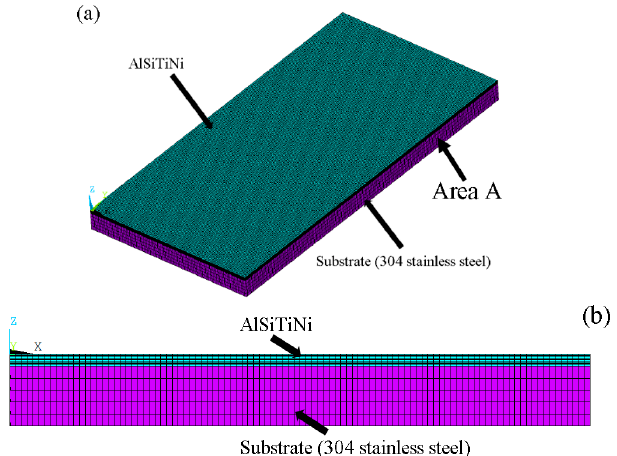
Figure 5. The mesh of the finite element (FE) model: ( a ) overall view of the model; ( b ) cross-sectional view of the model.